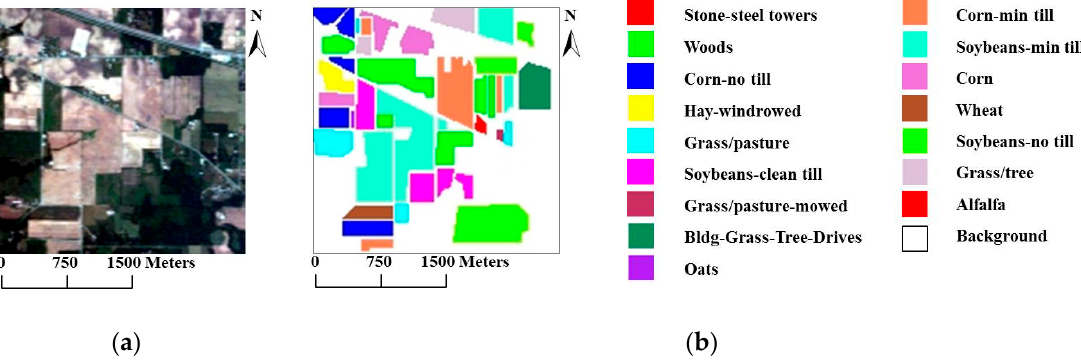
Figure 4. ( a ) True-color composite of the Airborne Visible/Infrared Imaging Spectrometer (AVIRIS) Indian Pines scene; ( b ) Ground reference map containing 16 mutually exclusive land-cover classes.